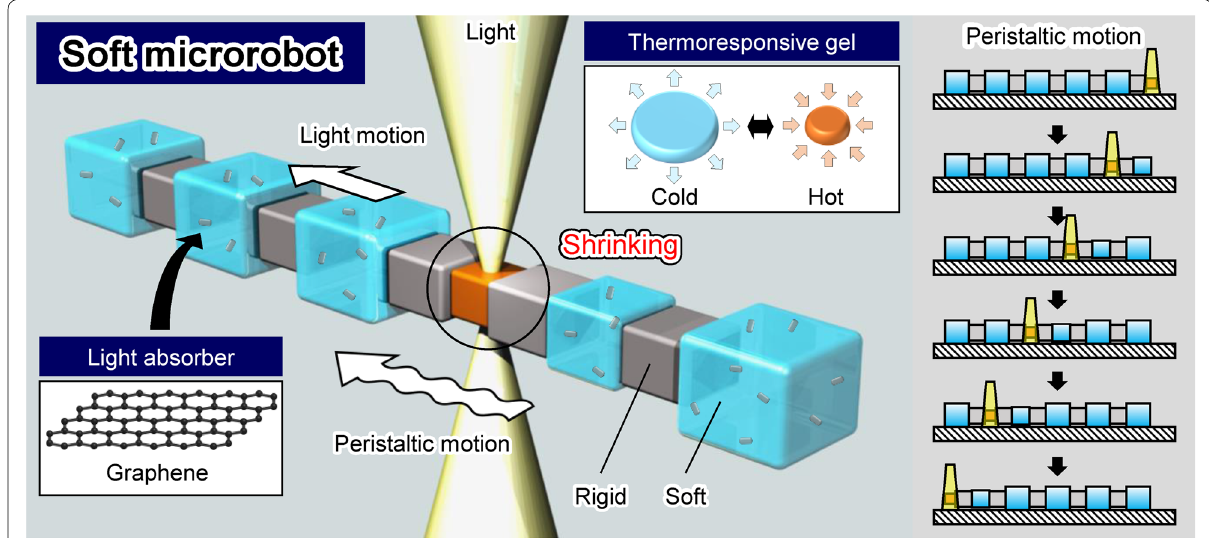
Fig. 2 Concept of soft microrobot having with soft-rigid hybrid